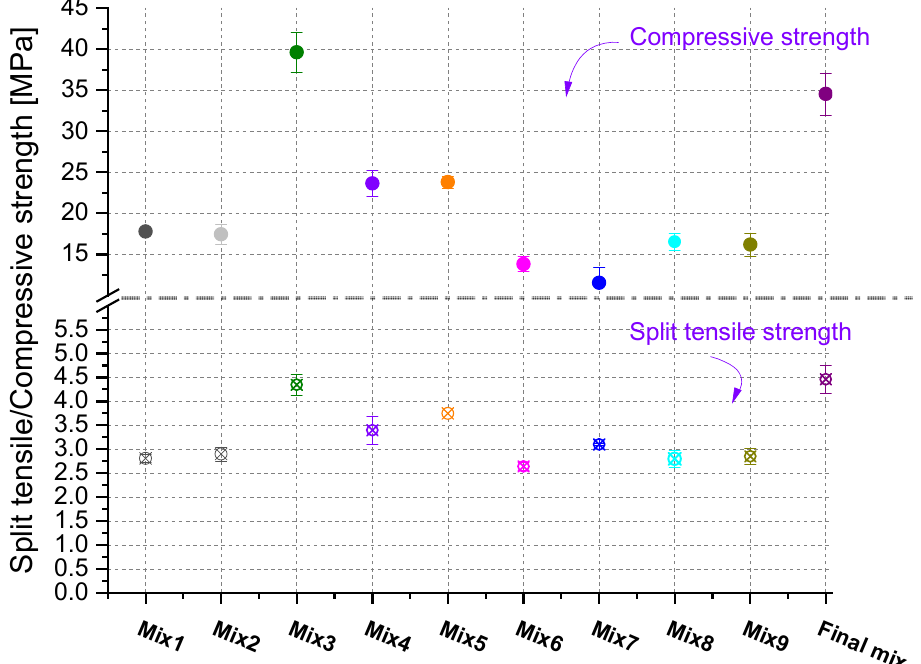
Figure 7. Split tensile and compressive strength of the pavers from various mixes.